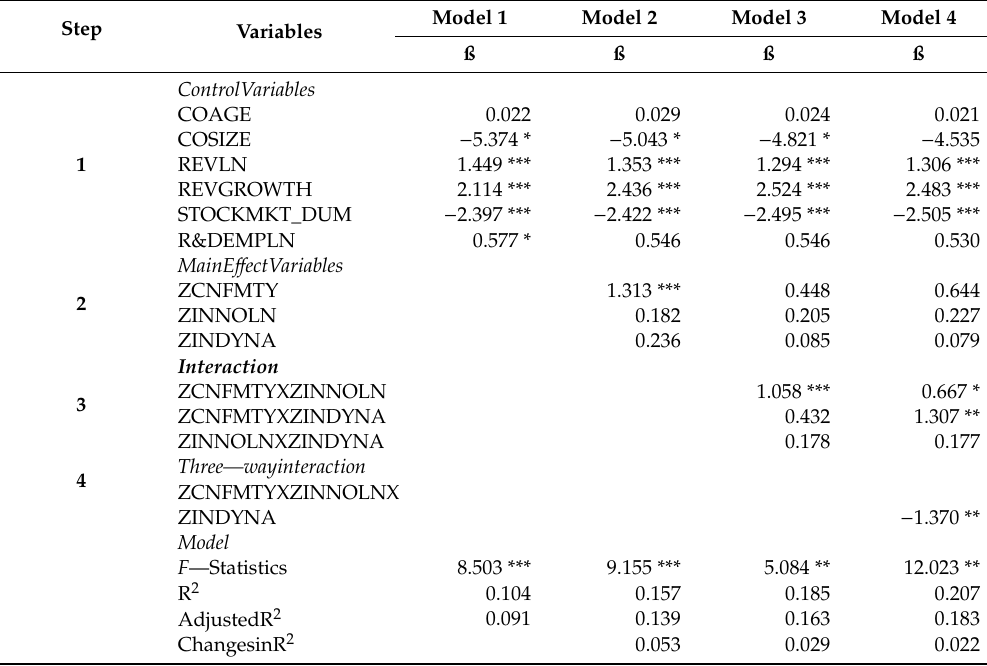
Table 2. Multiple Hierarchical Regression for Return on